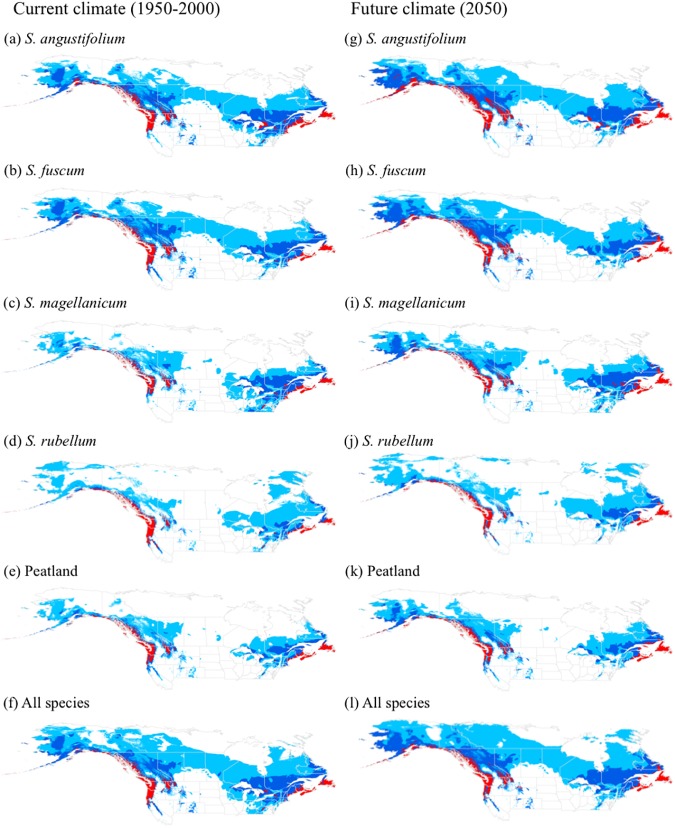
Sphagnum species distributions modelled under current and future climate projections using Maxent.Future maps indicate mean suitability based on three general circulation models. Red, highly suitable; blue, moderately suitable; turquoise, low suitability climate; white, unsuitable.